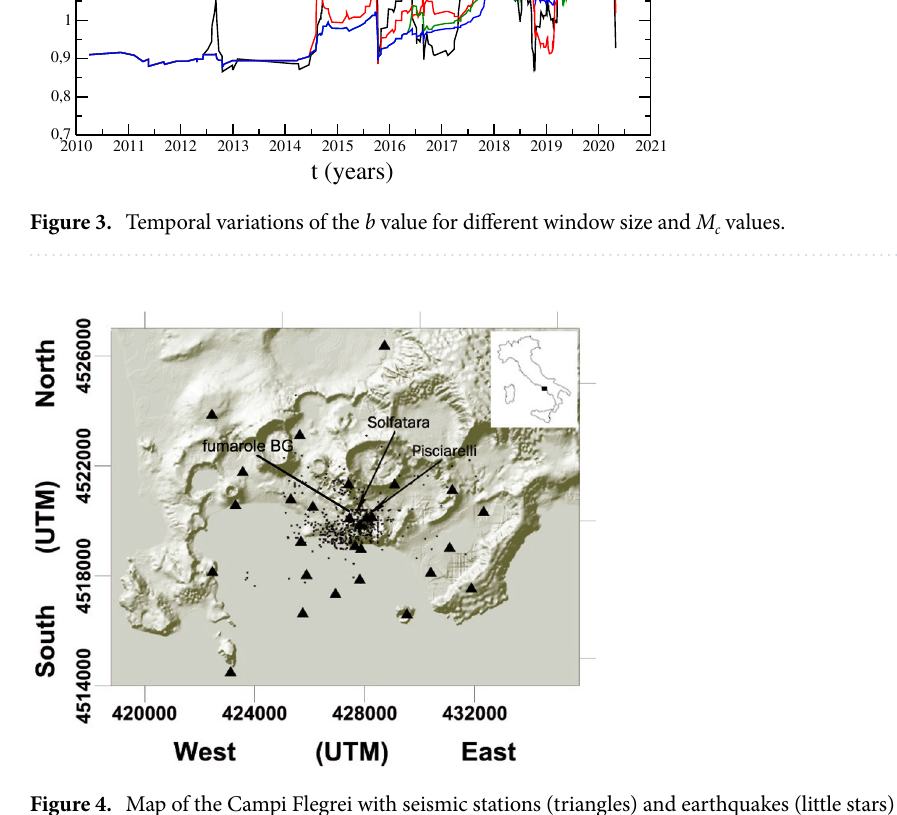
Figure 4. Map of the Campi Flegrei with seismic stations (triangles) and earthquakes (little stars) positions. Pisciarelli and Solfatara vents are indicated with arrows. The map is produced with Surfer v20, https:// www. golde nsoft ware. com/ produ cts/